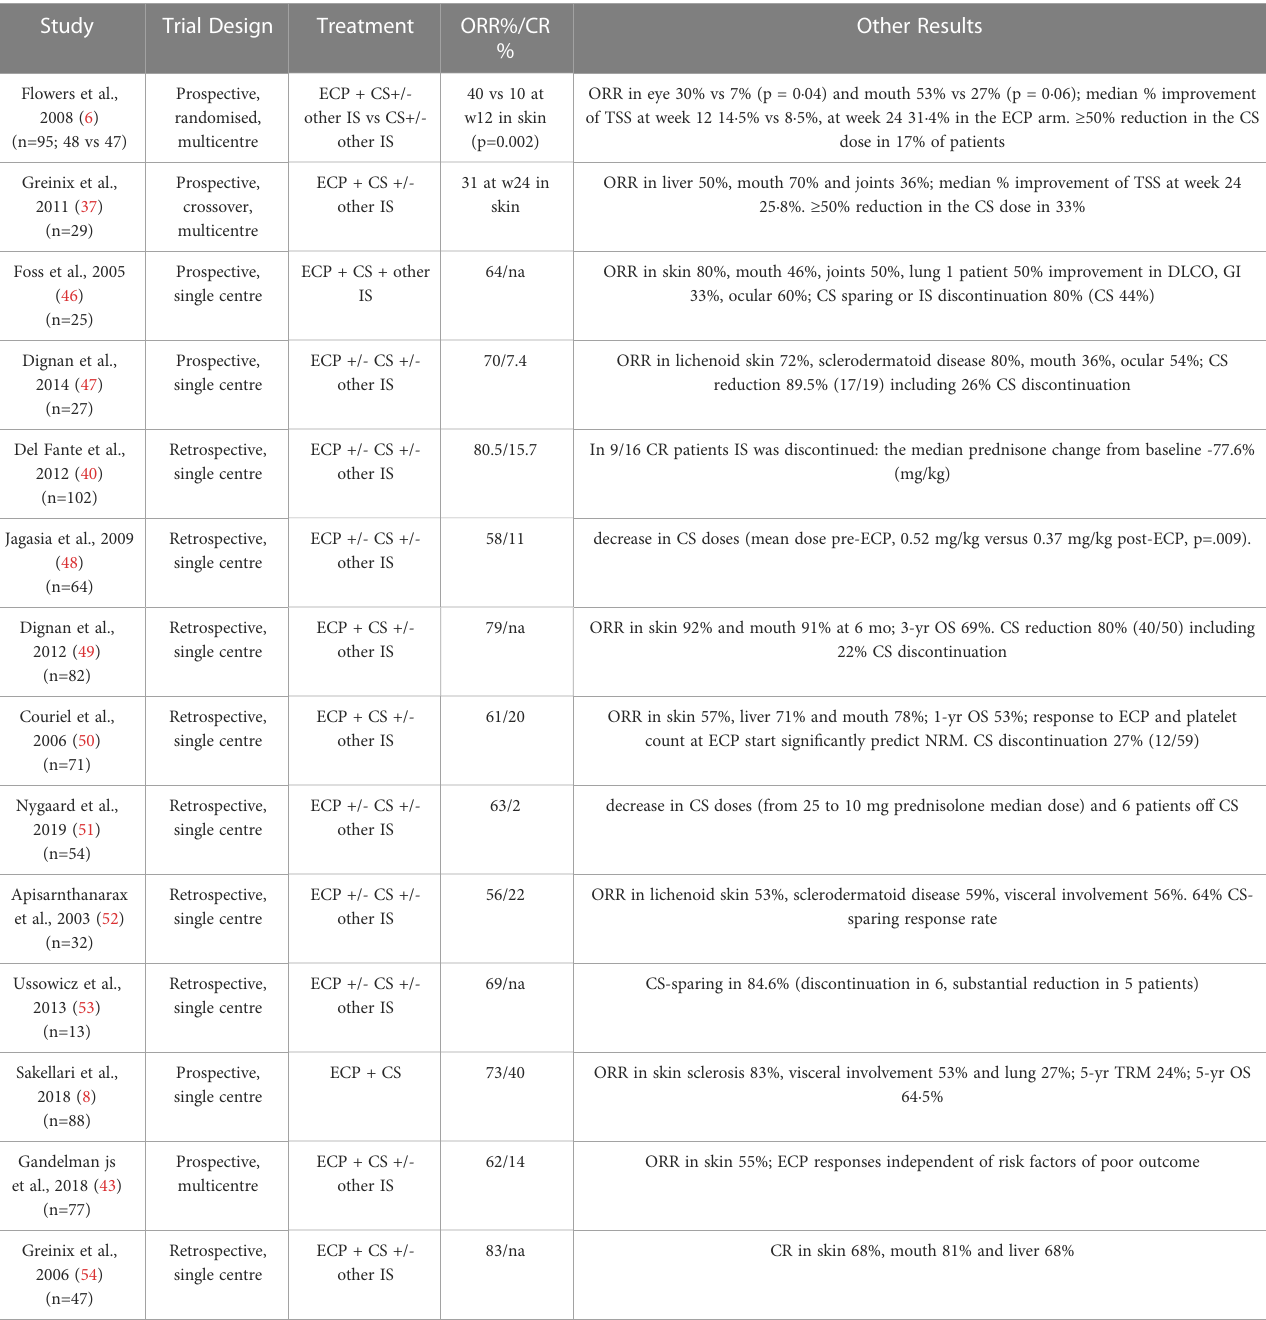
TABLE 3 ECP in treatment of steroid-refractory chronic GHD. Adapted from (45). Study Trial Design Treatment ORR%/CR